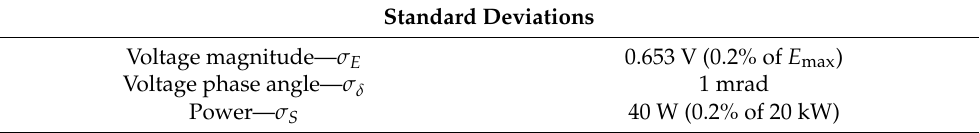
Table 1. Measurement standard